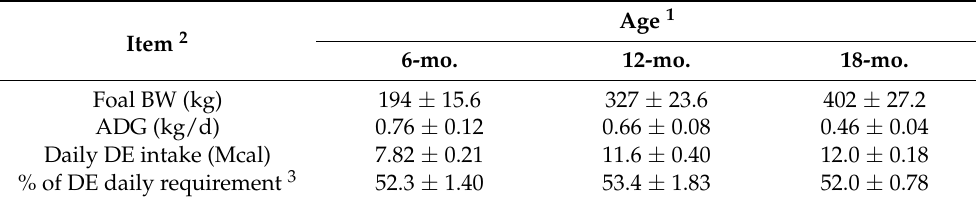
Table 6. Body weight (BW, kg), average daily gain (ADG, kg/d) and intake of energy from compound feed in foals at different growth